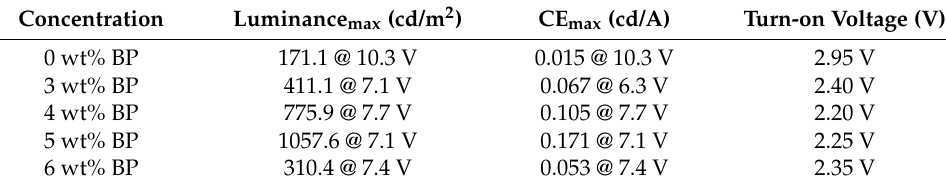
Table 1. Summarized performance of PeLEDs without and with the BP crystallizing agent.